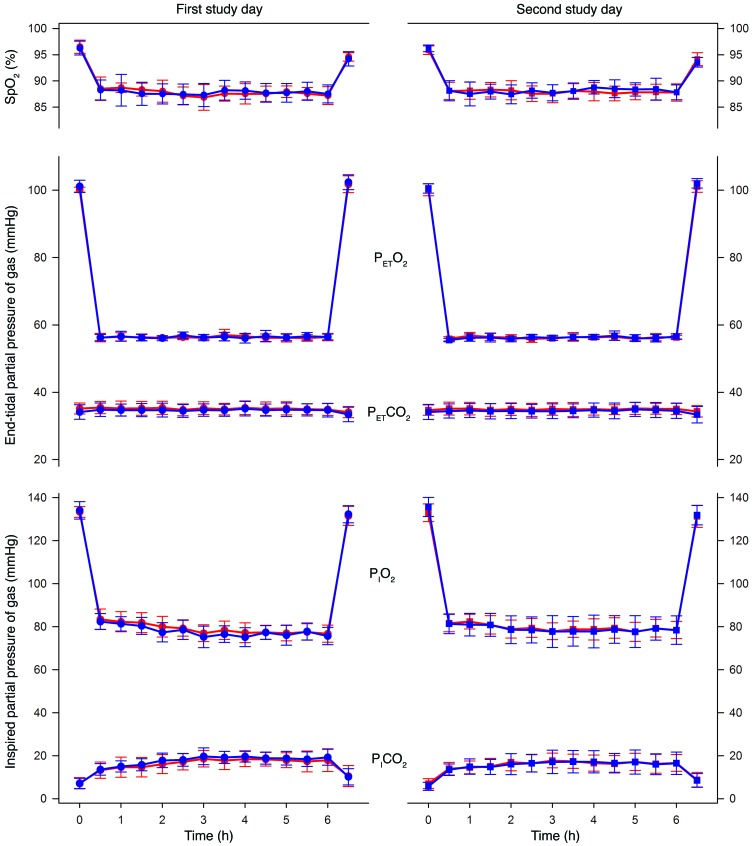
Peripheral oxyhemoglobin saturation and partial pressures of oxygen and carbon dioxide on each study day.Left, first study day (circles); right, second study day (squares). Top panel, peripheral oxyhemoglobin saturation (SpO2); middle panel, end-tidal partial pressure of oxygen (PETO2) and carbon dioxide (PETCO2); bottom panel, inspired partial pressure of oxygen (PIO2) and carbon dioxide (PICO2). Data for the ID group are shown in red and for the IR group in blue (n = 13 in each group); data are means ± SD based on time-averaged continuous recordings.